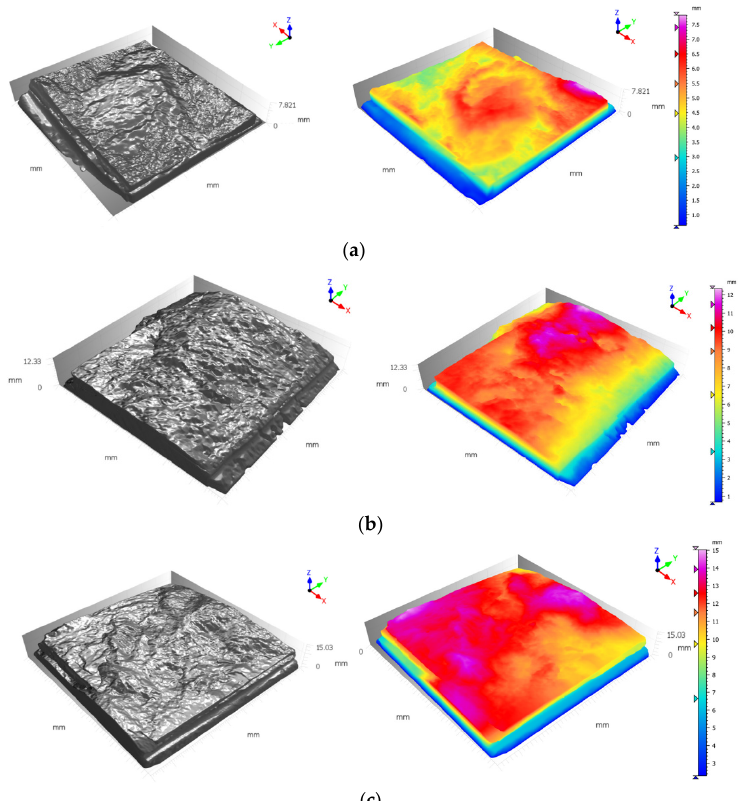
Figure 11. Digitized, 3D scans of the cement grouted fabricated rock joints used after direct shear test ( a ) JRC = 7.8 cement grouted w/c = 1:1, ( b ) JRC = 12.4 epoxy grouted, ( c ) JRC = 17.6 cement grouted w/c = 1:2.